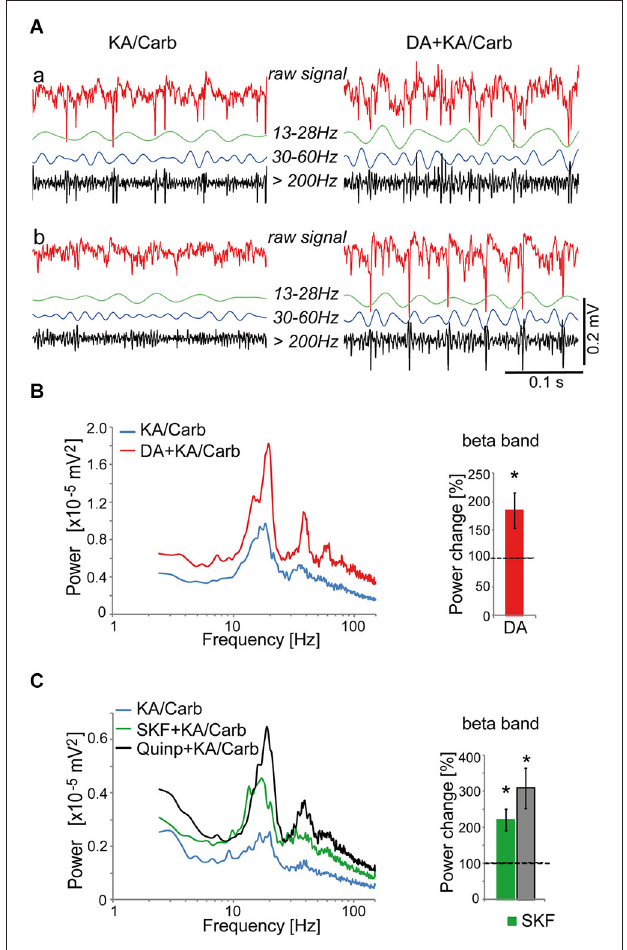
FIGURE 1 | Dopaminergic modulation of high-frequency oscillations in the anterior cingulate cortex (ACC). (A) Illustration of recordings from two ACC slices (a and b) superfused with kainate + carbachol (KA/Carb) in absence (left) and presence (right) of 50 µ M dopamine (DA). For each recording, the raw unfiltered signal (red), the filtered signals in the β band (13–28 Hz, green), γ band (30–60 Hz, blue) and high-frequency band ( > 200 Hz, black) are displayed. (B) DA significantly enhances the power of high-frequency oscillations (in the β band) induced by KA/Carb (two-tailed, P = 0.008, n = 8). Left : power spectra of recordings (mean of pooled data). Right : DA-induced change in the power of the oscillations (100% corresponds to the power of oscillations elicited by KA/Carb in absence of DA). * P < 0.05, significantly different from the KA/Carb condition. (C) The D2R agonist (quinpirole, Quinp, 1 µ M) and the D1R agonist (SKF-38393, SKF, 0.8 µ M) significantly enhance the power of the oscillations induced by KA/Carb (two-tailed, for Quinp: P = 0.003; for SKF: P = 0.004, n = 11). Left : power spectra of recordings (mean of pooled data). Right : Change in the power of the oscillations induced by Quinp and SKF, respectively (100% corresponds to the power of oscillations elicited by KA/Carb in absence of DA agonists). * P < 0.05, significantly different from the KA/Carb condition after Bonferroni correction. Bars, sem.